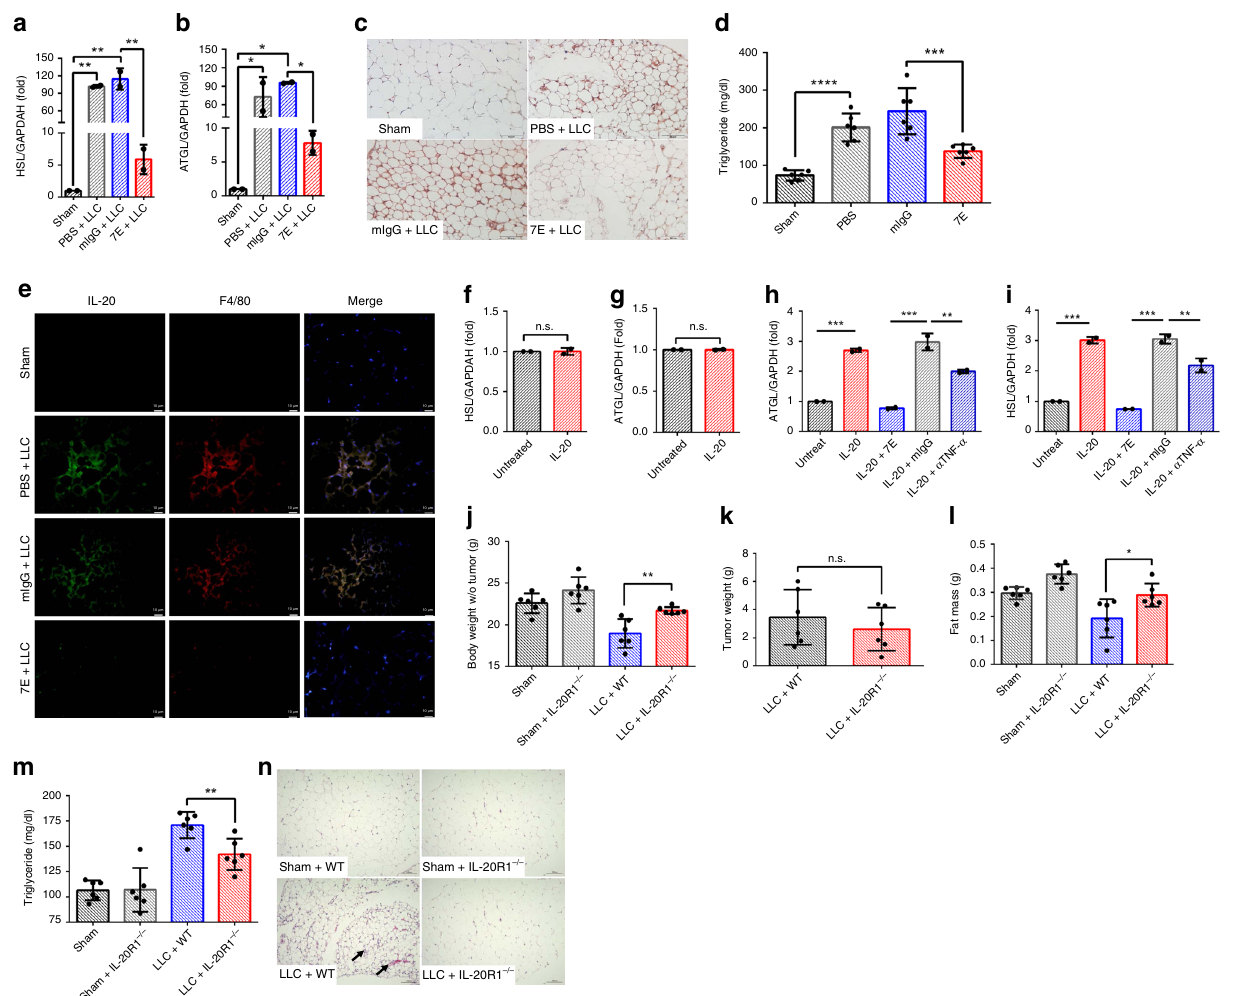
Fig. 7 7E alleviated LLC tumor-induced cachectic lipolysis in mice, and IL-20R1 de fi ciency mitigated LLC tumor-induced cachexia symptoms. LLC tumor-bearing mice were injected (i.p.) with PBS, mIgG, or 7E ( n = 6) twice per week throughout the study. Sham controls ( n = 6) were not injected with cancer cells. The mRNA transcript levels of a HSL (one-way ANOVA, p = 0.0004) and b ATGL (one-way ANOVA, p = 0.0098) in the epididymal fat of LLC tumor-induced cachectic mice were analyzed using RT-qPCR. * p < 0.05, ** p < 0.01. c IHC staining for HSL + adipocytes in the epididymal fat of cachectic mice was performed. Scale bar, 50 μ m. d The serum levels of triglycerides in LLC model mice were measured on day 28. One-way ANOVA, p = 0.0098; *** p < 0.001, and **** p < 0.0001. e Immuno fl uorescence staining showed the colocalization of IL-20 (green) and F4/80 + macrophages (red) in epididymal fat tissue samples. Nuclei were stained with DAPI (blue). Original magni fi cation: ×400; scale bar, 10 μ m. f , g The mRNA transcript levels of HSL and ATGL in adipocytes were analyzed using RT-qPCR. h , i RT-qPCR showed that conditioned medium from IL-20-treated LLC cells upregulated the expression of HSL and ATGL and that conditioned medium from 7E- or anti-TNF- α antibody-treated LLC cells inhibited IL-20-induced HSL and ATGL expression. One-way ANOVA, p < 0.0001; ** p < 0.01, *** p < 0.001. LLC tumor cells were injected (s.c.) into the right fl ank of WT ( n = 6) and IL-20R1 − / − mice ( n = 6). On day 26 posttreatment, the j tumor-free body weight (Mann – Whitney U test, p = 0.022), k tumor weight, and l epididymal fat mass (Mann – Whitney U test, p = 0.0152) of the mice were determined. m Serum levels of triglycerides were measured by ELISA. Mann – Whitney U test, p = 0.0087. ** p < 0.01. n Epididymal fat sections from the mice were stained with H&E for histological analysis. Arrows indicate immune cell in fi ltration. Scale bar, 100 μ m. Data are shown as the mean ± SD. Statistical signi fi cance was determined by one-way ANOVA Sidak ’ s multiple comparisons test ( a , b , d , h , i ), paired t test ( f , g ), or Mann – Whitney U test ( j , l , m ). The experiments in a , b , f – i were repeated three times independently with similar results, and the data of one representative experiment are